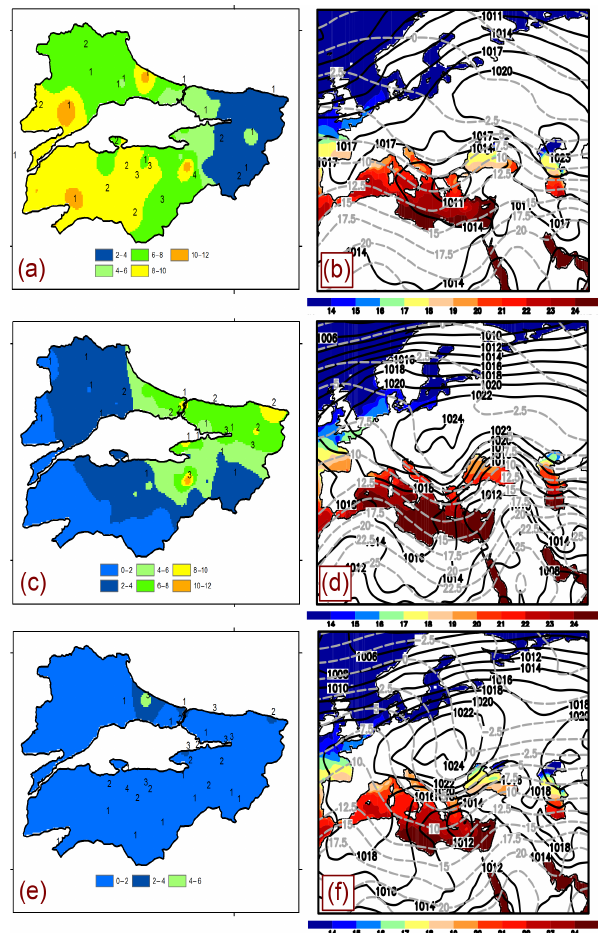
Figure 6. (a) Daily mean precipitation values of cyclonic precipita- tion types (mm, shaded) and the counts of EP days for the stations of Marmara during the autumn of 2006–2015. (b) Composites of the daily mean sea level pressure (MSLP, solid lines), sea surface temperature (SST, colored), and air temperature at 850hPa (dashed lines) for the average of 18 extreme precipitation days over Mar- mara. (c) Same as (a) but for the sea effect (NE) precipitation types. (d) Same as (b) but for the 14 extreme precipitation days. (e) Same as (a) but for the convective (E) precipitation types. (f) Same as (b) but for the 11 extreme precipitation